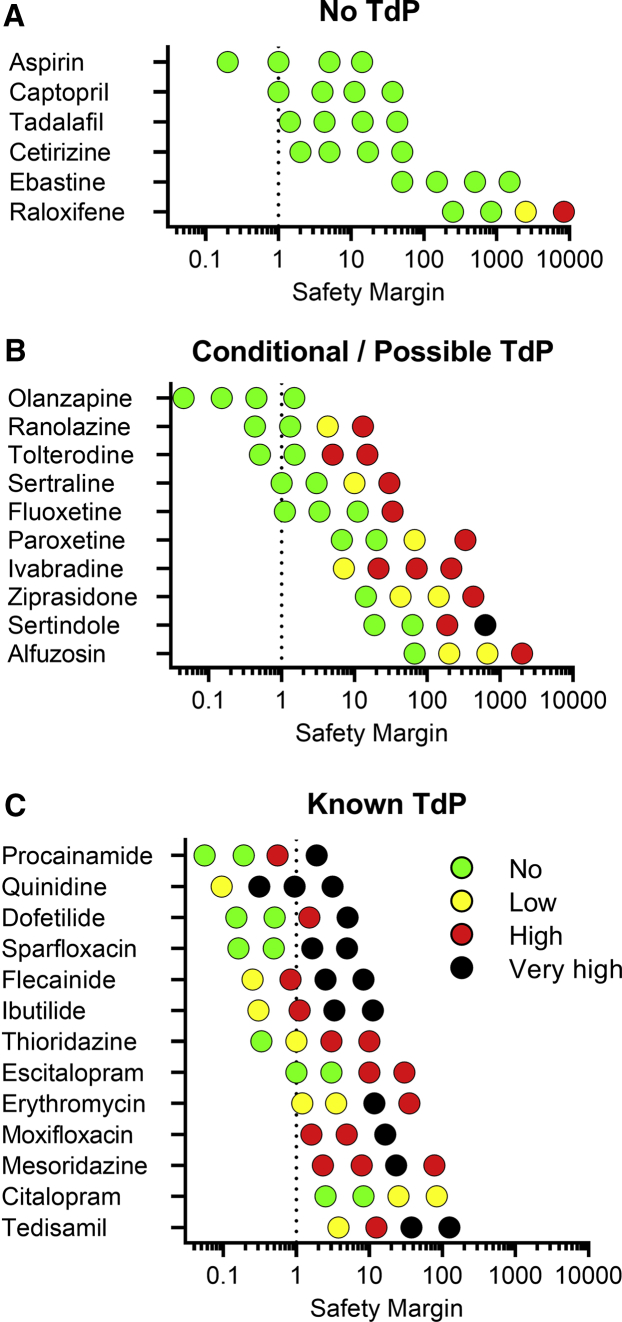
Relationship between Hazard Scoring and the Clinical Safety Margin for TdP Risk(A–C) (A) No TdP, (B) conditional and possible TdP, and (C) known TdP risk compounds plotted in function of their safety margin (tested concentration/free Cmax). Dotted line reflects the free Cmax.